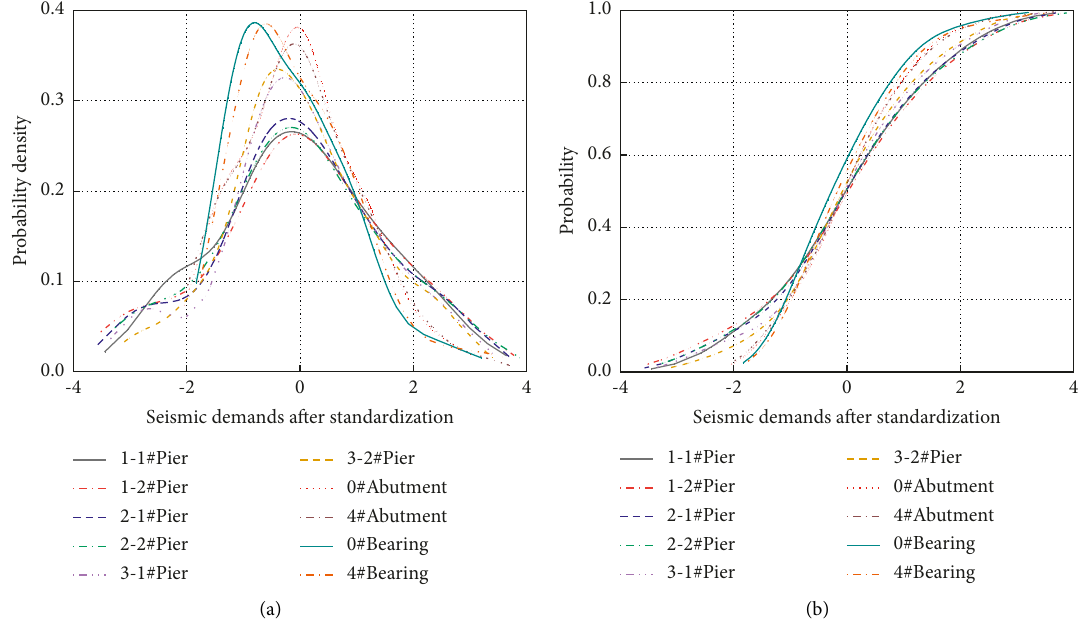
Figure 7: Probabilistic functions of transformed seismic demands: (a) density functions and (b) distribution functions.